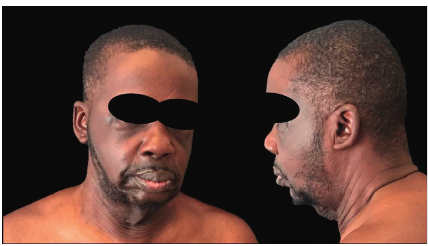
Figure 1: At the age of 35: appearance of premature aging; wrinkly face with profound laxity notable in the periocular skin and neck region.